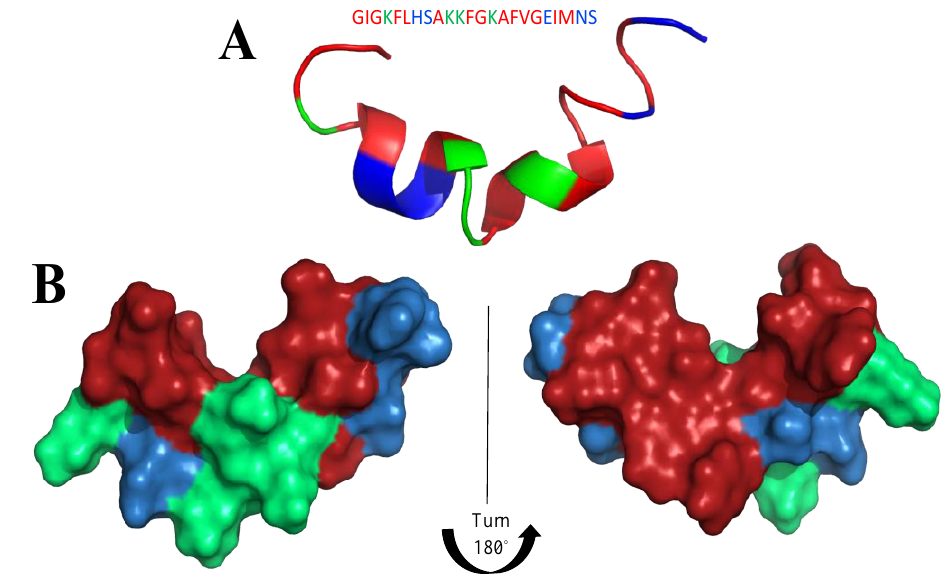
Figure 14. Structure of Magainin-2 (PDB: 2LSA) as a representative of the magainin protein family. ( A ) Ribbon model ( B ) Surface model: left and right side. In blue: hydrophilic amino acids, in green: positively charged amino acids; in red: hydrophobic amino acids.